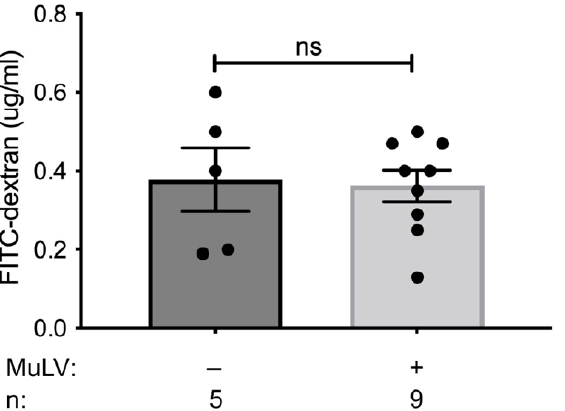
Figure 4. Intestinal permeability is unaffected by MuLV infection. FITC permeability assay was used to determine the permeability of the intestines in SPF BALB/cJ infected and uninfected mice. Each data point is an individual plasma sample. n, number of mice used. p -value calculated using unpaired t -test. ns, not significant.